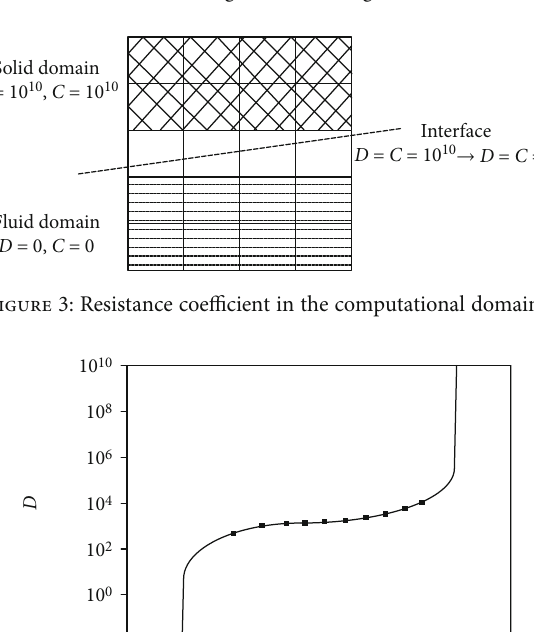
Figure 2: Schematic diagram of burning surface in mesh.